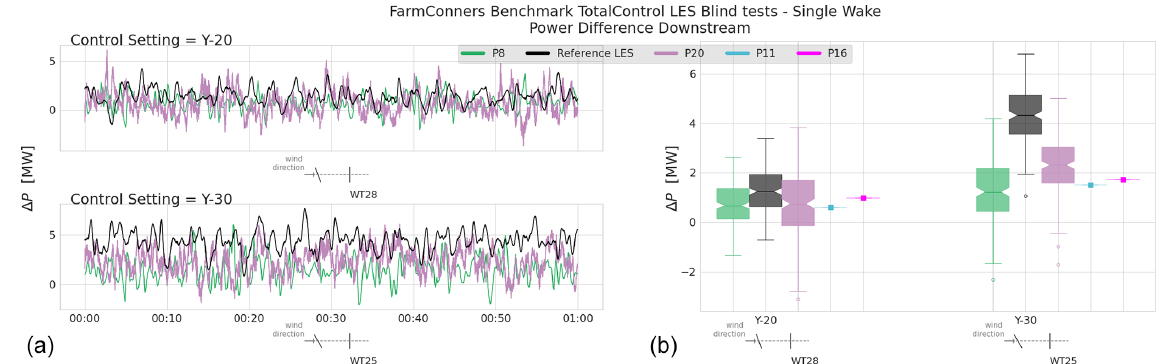
Figure B2. TotalControl LES, single wake under wake steering power difference, (cid:49)P , comparison for the downstream turbines WT28 (behind − 20 ◦ yawed turbine) and WT25 (behind − 30 ◦ yawed turbine). (a) Time series of (cid:49)P at the downstream turbines illustrated at the submitted frequency by the participants. (b) The distribution of (cid:49)P within the 1h blind test period. For both 20 and 30 ◦ anticlockwise yaw misalignment WFFC